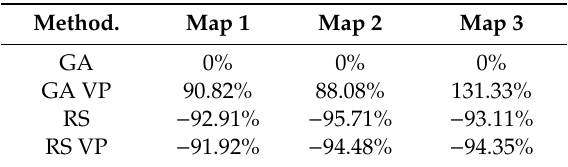
Table 7. Percentage difference between execution times of the methods. genetic algorithm with approximation GA times as a reference.